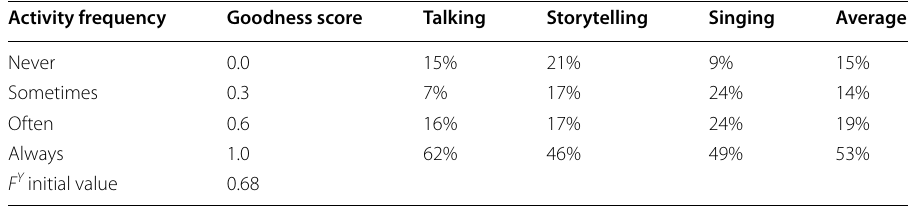
Table 8 Average percentage of children per socio-economic quintile per education level Parental educational level Goodness score Quintiles 1–3 Quintiles None or